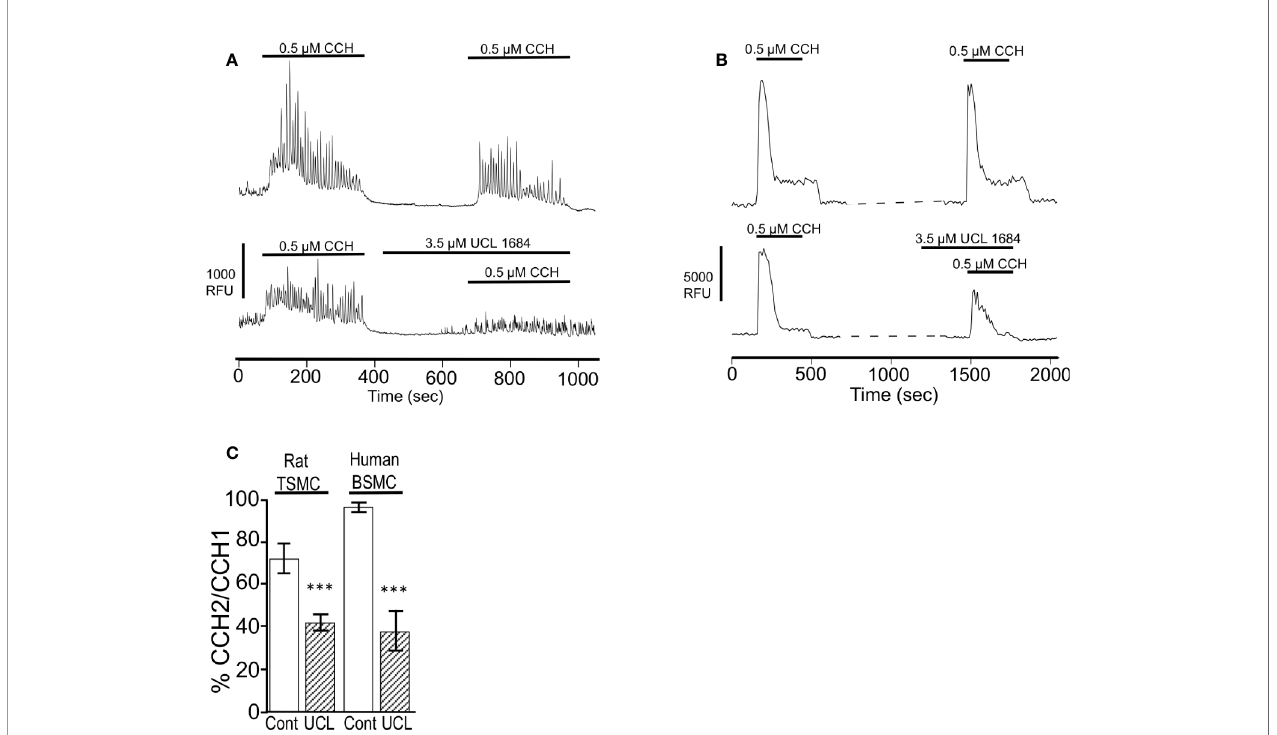
FIGURE 6 | UCL 1684 causes a reduction of cholinergic-evoked calcium release. (A) Representative cytoplasmic calcium response of acutely isolated rat tracheal smooth muscle cells to repetitive 0.5 m M carbachol application without (upper panel) and with 3.5 m M UCL 1684 preceding second carbachol challenge (bottom panel). (B) Representative cytoplasmic calcium response of human bronchial smooth muscle cells to repetitive 0.5 m M carbachol application without (upper panel) and with 3.5 m M UCL 1684 preceding second carbachol challenge (bottom panel). (C) Summary data from A and B. Data is the average percent change of calcium response (integral) to repeated carbachol treatment without (white column) and with UCL 1684 (hashed column) preceding the second challenge. Measurements were from tracheal smooth muscle cells (TSMC, as in A) and human bronchial smooth muscle cells (BSMC, as in B). Rat TSMC control was 0.72 ± 0.07, N=27, UCL 1684 treated was 0.42 ± 0.04, N=40, P < 0.001. Human BSMC control was 0.97 ± 0.03, N=25, UCL 1684 treated was 0.38 ± 0.10, N=16, P < 0.0001. Comparisons were analyzed using a paired Student ’ s